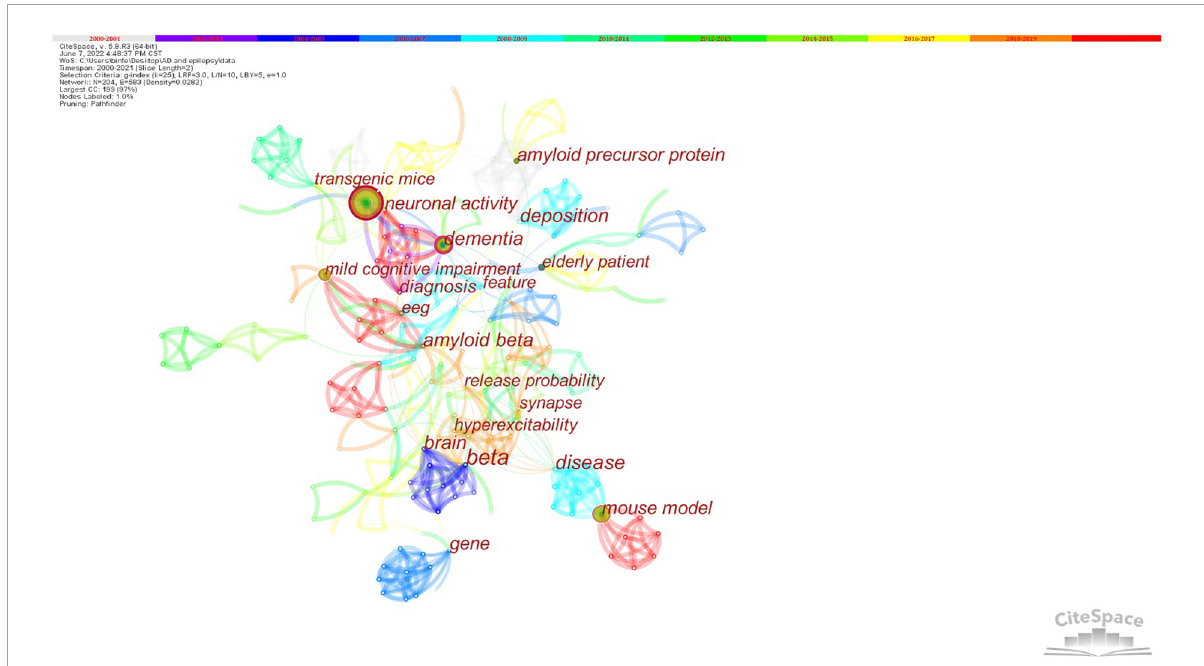
FIGURE7 Analysis of co-occurrence Keywords. Nodes represent keywords, and the size of each node corresponds to the co-occurring frequency of the keywords. The color of the lines that appear together between keywords indicates chronological order: grey represents the oldest, and orange the newest. “beta” had a highest degree of